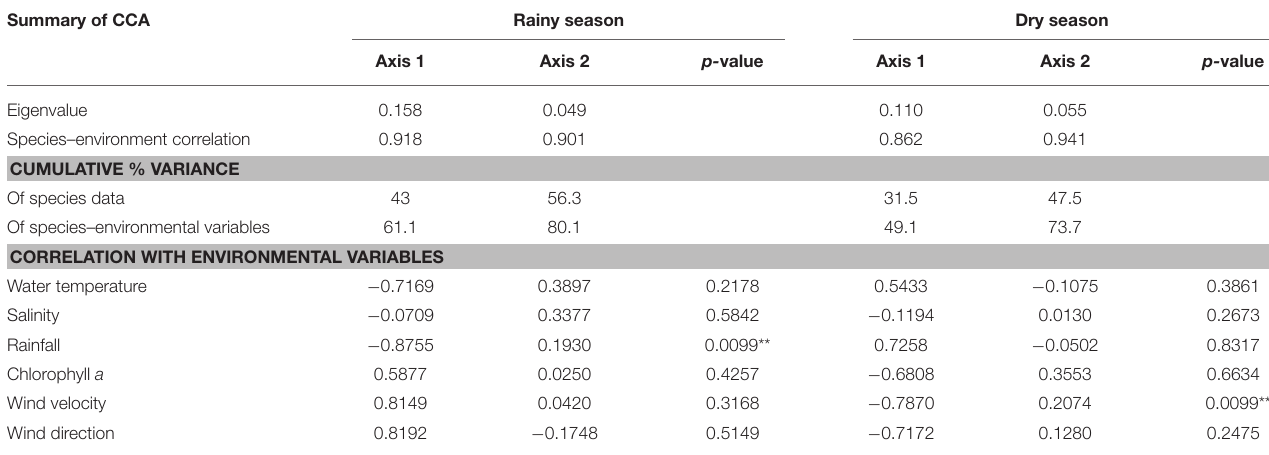
TABLE 3 | Summary of canonical correspondence analysis (CCA) using six environmental variables (water temperature, salinity, rainfall, chlorophyll a , wind velocity and wind direction) and density of fish larvae species, fish eggs, larval species habitats and plastic debris in the Saint Peter and Saint Paul